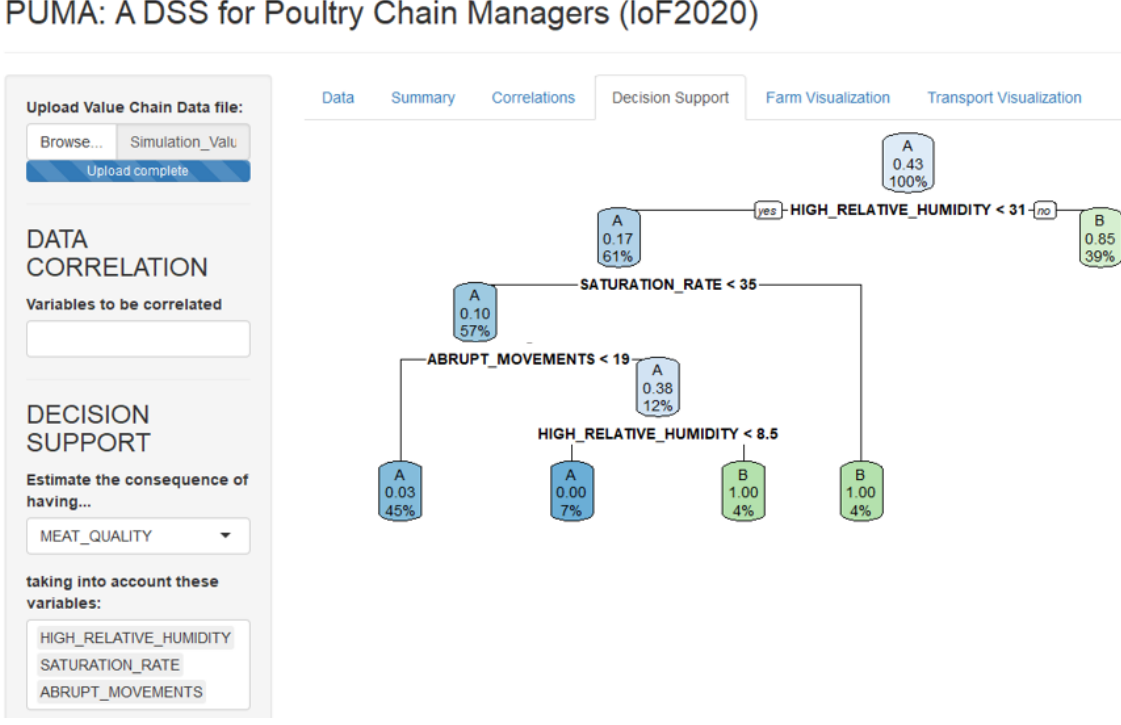
Figure 7. Screenshot of the PUMA